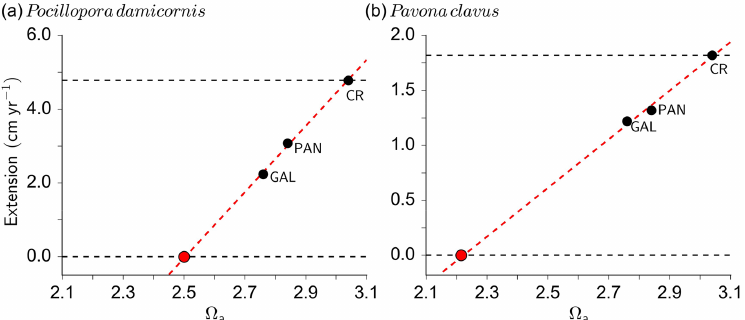
Figure 6. Mean aragonite saturation states ( (cid:127) a ) – from present and former studies – versus previously reported mean linear extension rates of (a) Pocillopora damicornis and (b) Pavona clavus from upwelling areas in Costa Rica (CR) (Jiménez and Cortés, 2003), Panama (PAN) and Galápagos (GAL) (Manzello, 2010a). The red dotted line shows the regression equation as estimated by Rixen et al. (2012). The red mark represents our estimated (cid:127) a threshold for Bahía Culebra, when coral growth equals